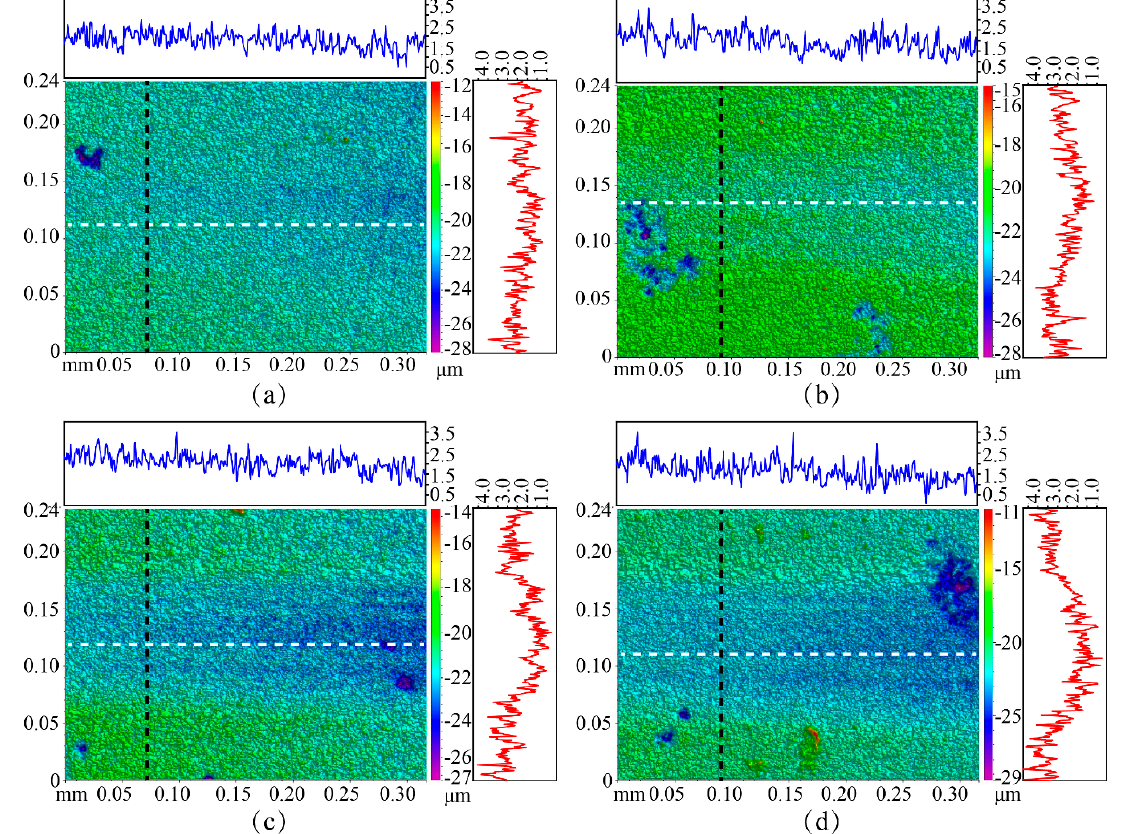
Figure 6. WL interferometer reconstructed results of fs laser-irradiated regions under different pulse